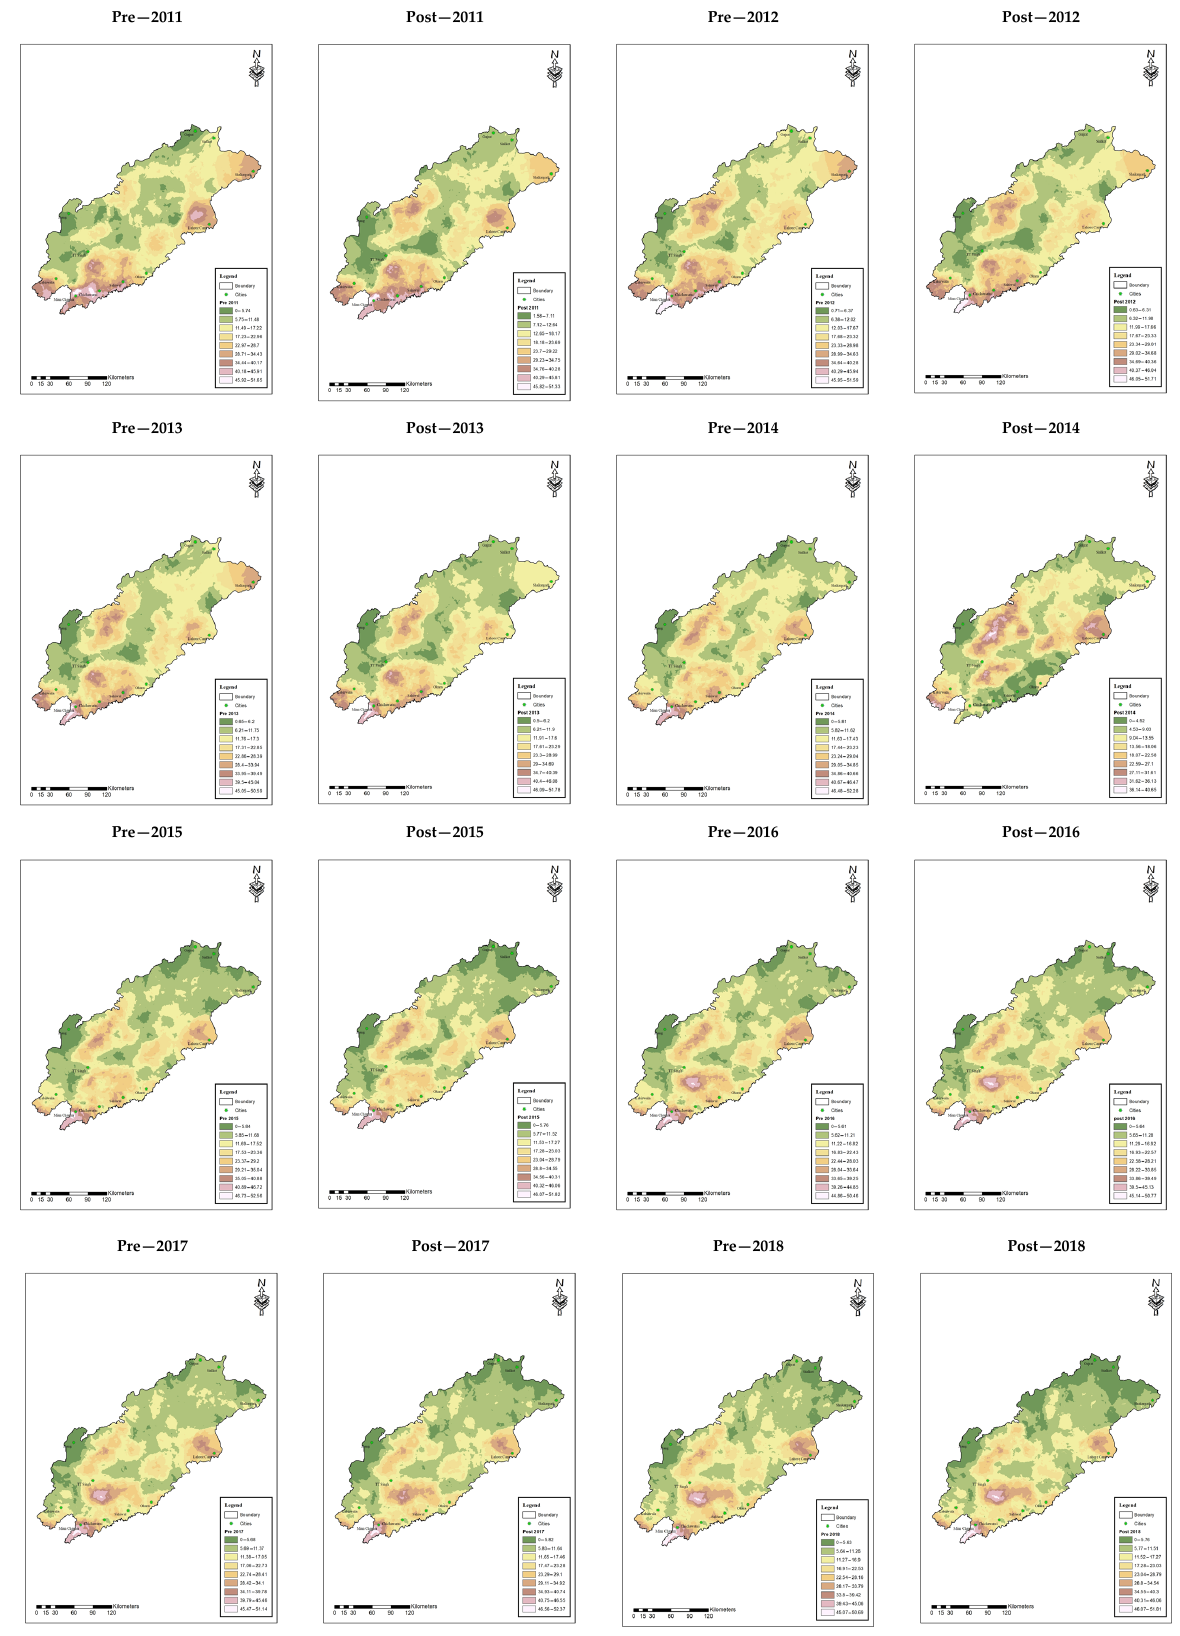
Figure 9. Interpolation of groundwater levels for pre- and post-monsoon from 2003 to 2018. From these trends, the maximum groundwater depths from 2003 to 2018 vary from 5.91 m to 15.45 m resulting in a 9.54 m (0.61 m/year) drawdown in groundwater depth. For checking the results, a comparison is made between the net deficit and average groundwater levels for the year 2015–2016. The average groundwater depth in 2015 was 6.33 m while it is 6.18 m in 2016 which corresponds to a 0.15 m drawdown. While the net deficit in 2016 was 0.05665 m (56.65 mm), the remaining 0.09 m is used by domestic, in- dustries, etc. In comparison to this study, Qureshi et al. [33] reported that groundwater levels in most of the irrigated parts of the study area have a drawdown up to 6 m which directly increases the pumping cost due to deep well boring. 3.6. Highly Stressed Areas To check the possible cause of stress on groundwater, highly stressed areas in the LCC are identified from groundwater depths. The highly stressed areas are Faisalabad, Sheikhupura, and Toba Tek Singh where the groundwater is depleting abruptly. Average groundwater depletion is 9.54 m (0.58 m/year). Reasons for rapid drawdown are due to different causes such as cropping effect, climatic effect, and effect due to tubewell density. 3.7. Cropping Effect Since, for high delta crops, crop water requirement is high, the effect of crops is ana- lyzed based on the historical data for the highly stressed areas as shown in Figure 10. In Faisalabad, rice, sugarcane, fodder, and maize cover 6%, 31%, 30%, and 13%, respectively, in the Kharif season while wheat is covering more than 70% area in the Rabi season. Sim- ilarly, for Sheikhupura and Toba Tek Singh, the results are summarized in Table 3. Rizwan et al. [40] proposed that if the command area of the LCC crop was cultivated with a crop- ping pattern containing wheat, rice, and cotton, with high-efficiency irrigation practices then surface water can be saved in a range between 2.768 Bm 3 and 3.699 Bm 3 .